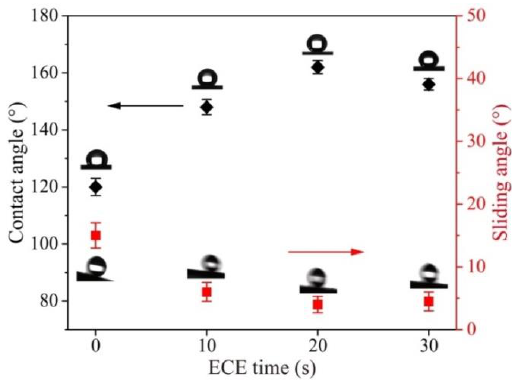
Figure 5. Static water contact angle and sliding angle on EDM surfaces under di ff erent ECE times.